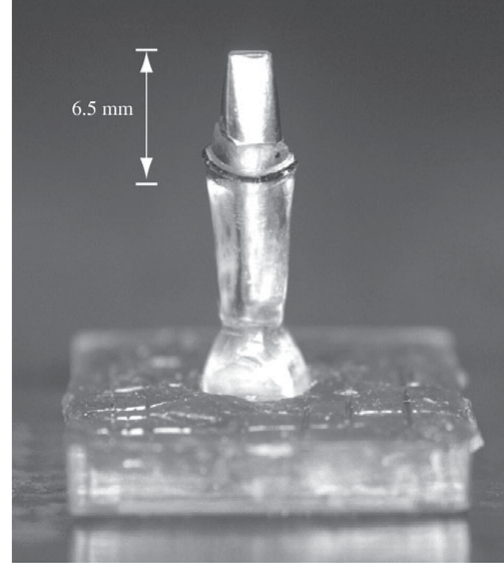
Figura 3. Cast restoration in the plastic